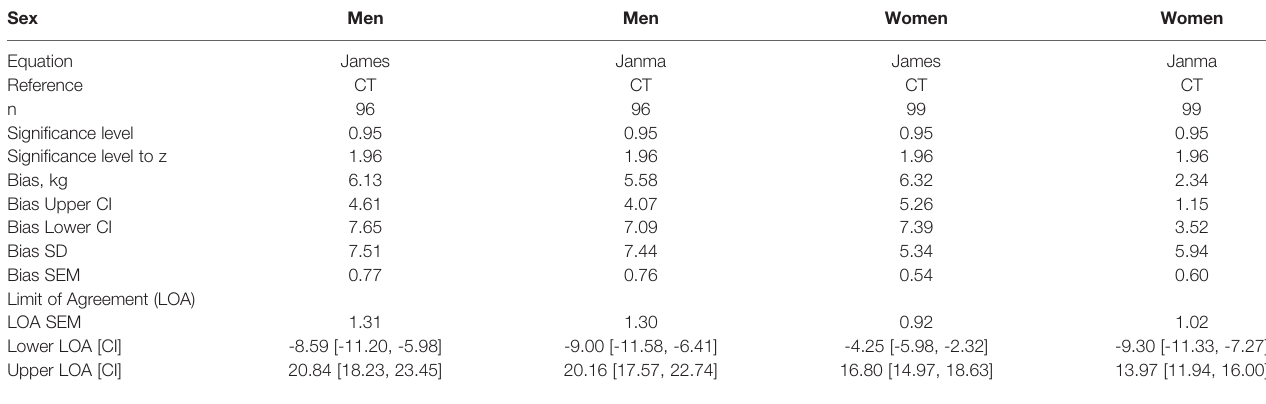
TABLE 3 | Bias and upper and lower limits of agreement between CT-de fi ned lean body mass (LBM CT ) and LBM estimated by the equations of James and Janmahasatian (LBM James , LBM Janma